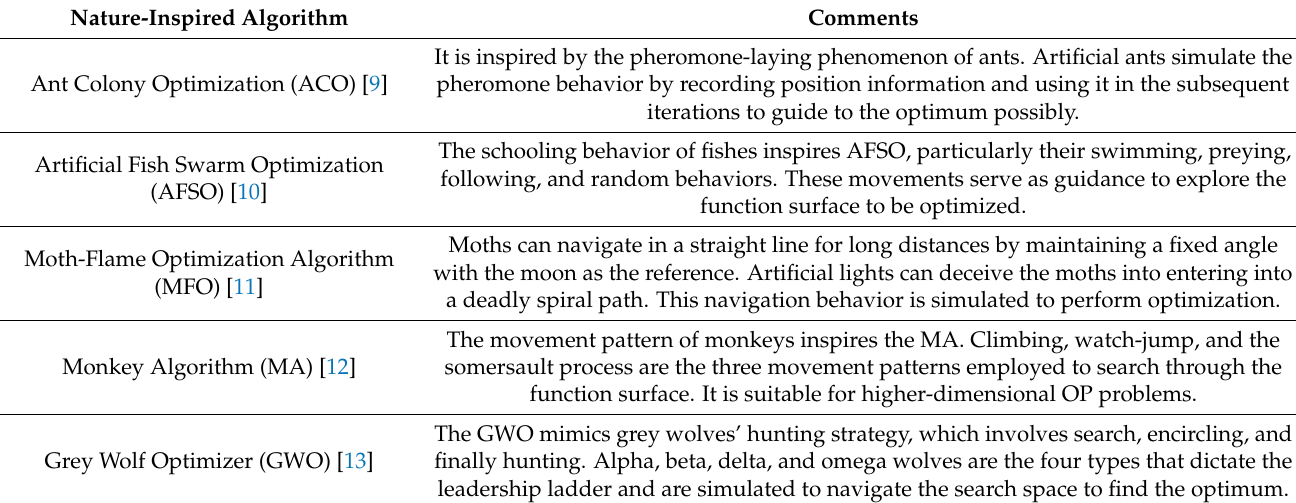
Table 1. A brief discussion on several nature-inspired OP